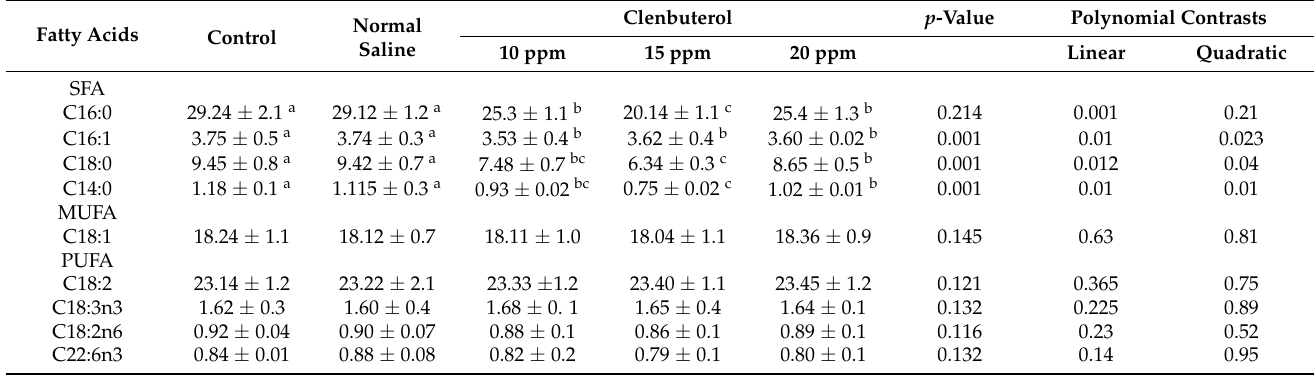
Table 6. Effect of in ovo feeding of clenbuterol on the breast muscle fatty acid profile (g/100 g fat) of chicken. Fatty Acids